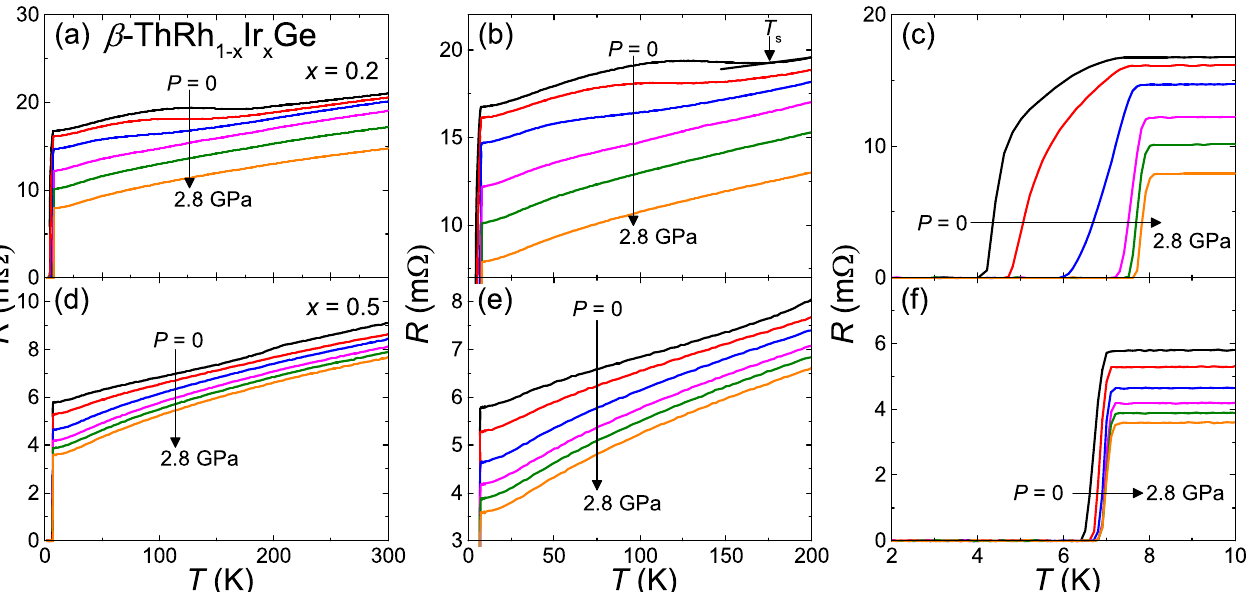
Fig. 5 High-pressure resistance data of β -ThRh 1 − x Ir x Ge at selected x values. a Temperature dependence of electrical resistance between 1.8 and 300 K under hydrostatic pressure P = 0, 0.5, 1, 1.5, 2, 2.8 GPa (from top to bottom) for the β -ThRh 1 − x Ir x Ge sample with x = 0.2. b Zoom of the data near the structural phase transition. c Zoom of the data near the drop to zero resistivity. d – f Same set of data for the sample with x = 0.5.